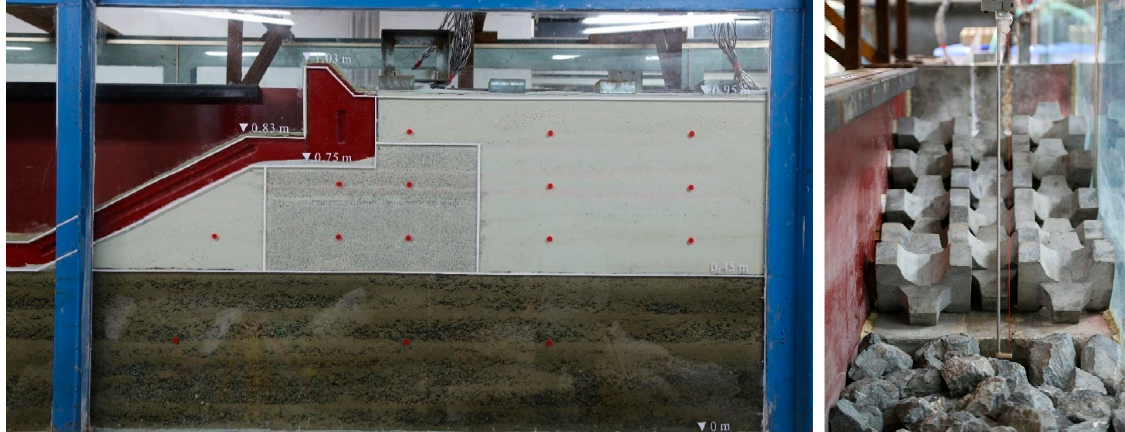
Figure 3. A real view of the completed physical model without accropodes or rubble in front of the revetment breakwater.